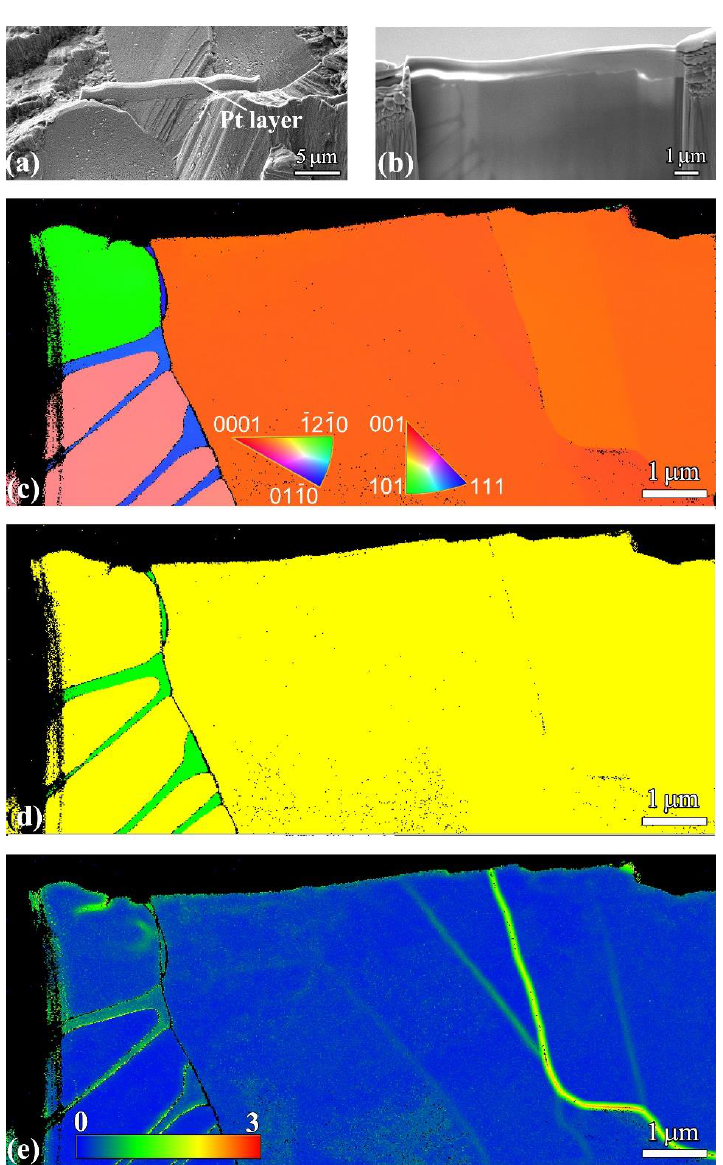
Figure 13. EBSD observation of extracted cross-section sample of the facet in location 2 in Figure 9i. ( a ): SEM image for FIB location; ( b ): SEM image of extracted cross-section sample; ( c – e ): EBSD results of the sample in ( b ), ( c ) is inverse pole figure map, ( d ) is phase map, in which the yellow and the green colors denote the alpha phase and the beta phase, respectively, ( e ) is the KAM